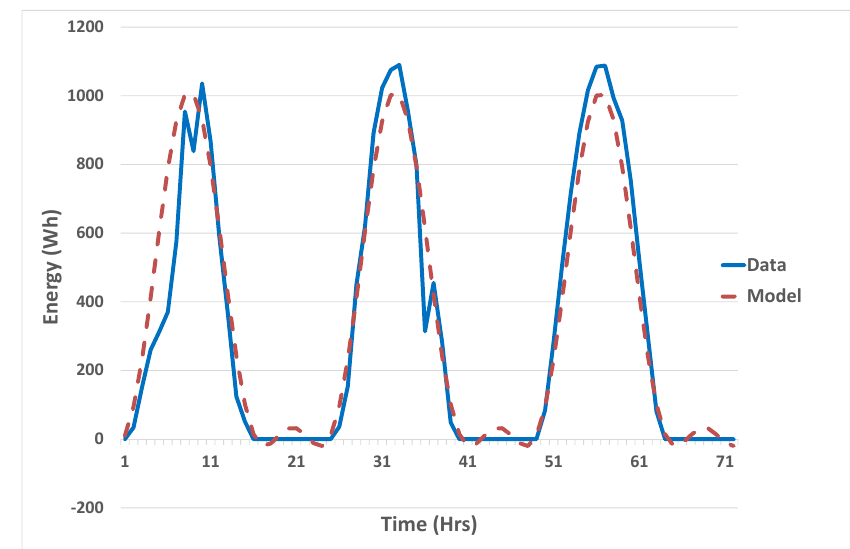
Figure 6. Effect of including sidebands on solar radiation.